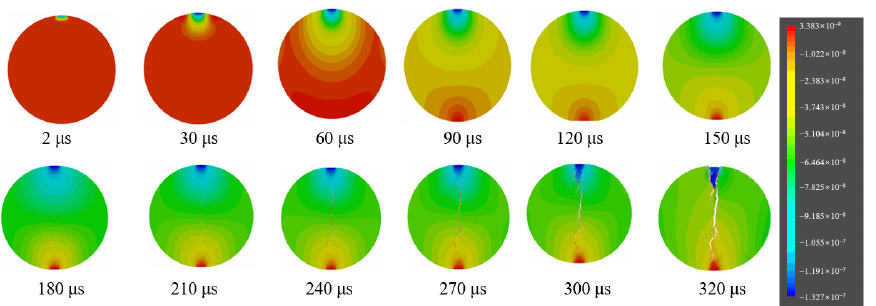
Figure 25. Dynamic splitting displacement field evolution of a typical Brazil disk coal specimen under impact load.